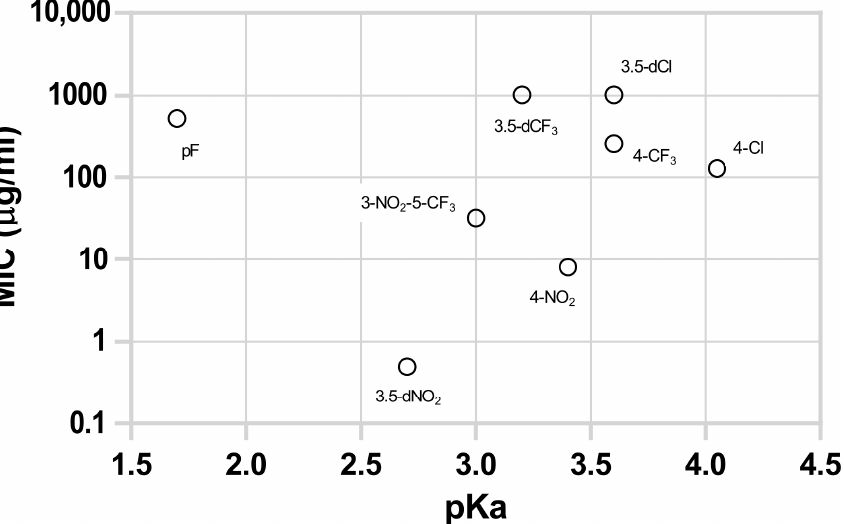
Figure 1. Antitubercular activity (MIC) against M. tuberculosis of eight decyl esters with different substituents in the benzoyl group in function of the pKa of the free acid liberated by hydrolysis. Aromatic substituents: 2,3,4,5,6-pentafluoro (pF), 3,5-dinitro (3,5-dNO 2 ), 3-nitro-5-trifluoromethyl (3-NO 2 -5-CF 3 ), 3,5-bis(trifluoromethyl) (3,5-dCF3), 4-nitro (4-NO 2 ), 3,5-dichloro (3,5-dCl), 4-trifluoromethyl (4-CF 3 ), and 4-chloro